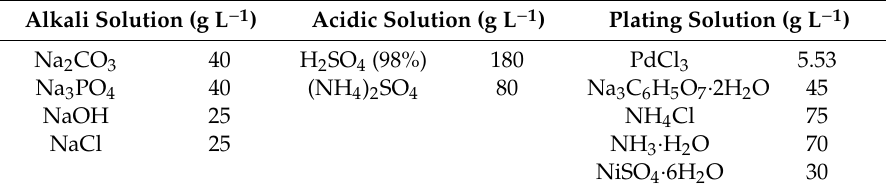
Table 1. Compositions of the alkali solution, the acidic solution, and the basic plating